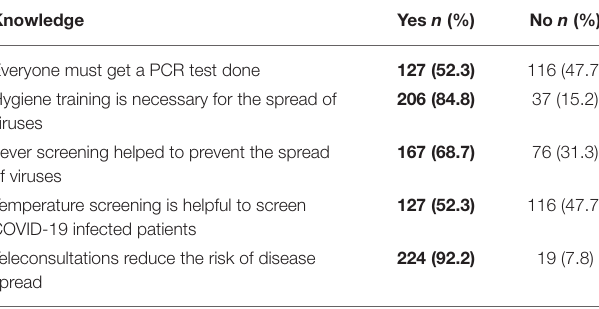
TABLE 2 | Perception on COVID-19 transmission and